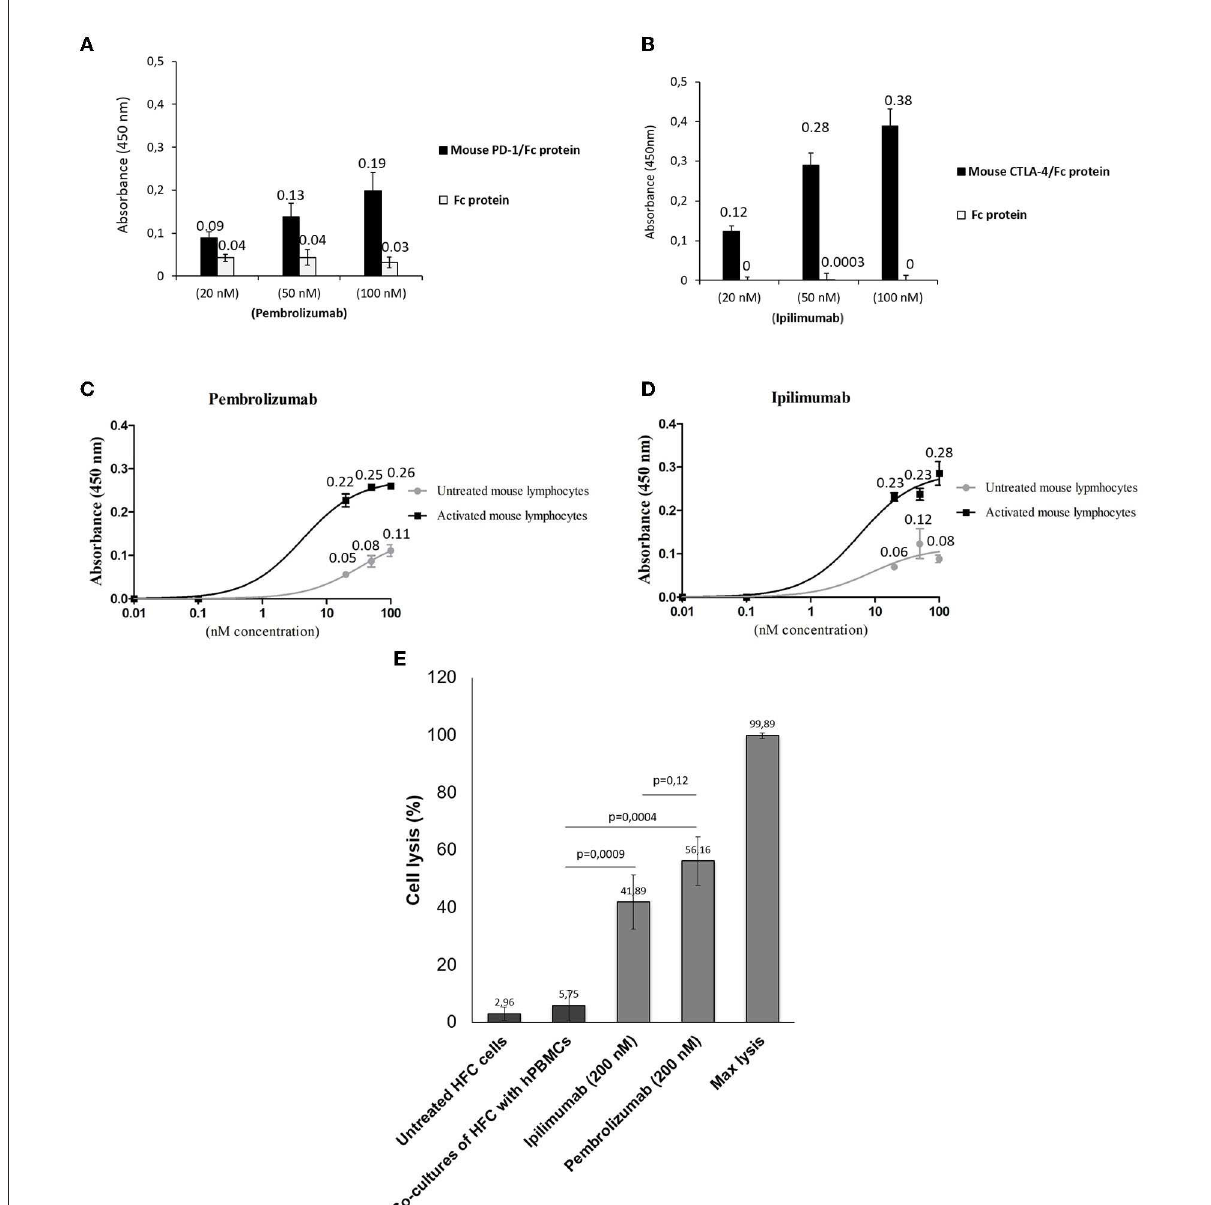
FIGURE1 Binding assays of Pembrolizumab and Ipilimumab on mouse PBMCs and on human and mouse purified recombinant target proteins. ELISA assays were performed by using the indicated antibodies at increasing concentrations on mouse (black bars) CTLA-4/Fc or PD-1/Fc (A,B) . The binding of antibodies was also tested on the Fc portion (empty bars), used as a negative control. Cell ELISA assays were performed by testing Pembrolizumab (C) ( n = 3) or Ipilimumab (D) ( n = 3) on mouse PBMCs untreated or activated with anti-CD3/CD28 beads. (E) LDH assay on the supernatant of co-cultures of HFC and hPBMCs treated as indicated ( n = 3). Cell lysis was measured as described in the materials and methods section. Error bars depict means ± SD.